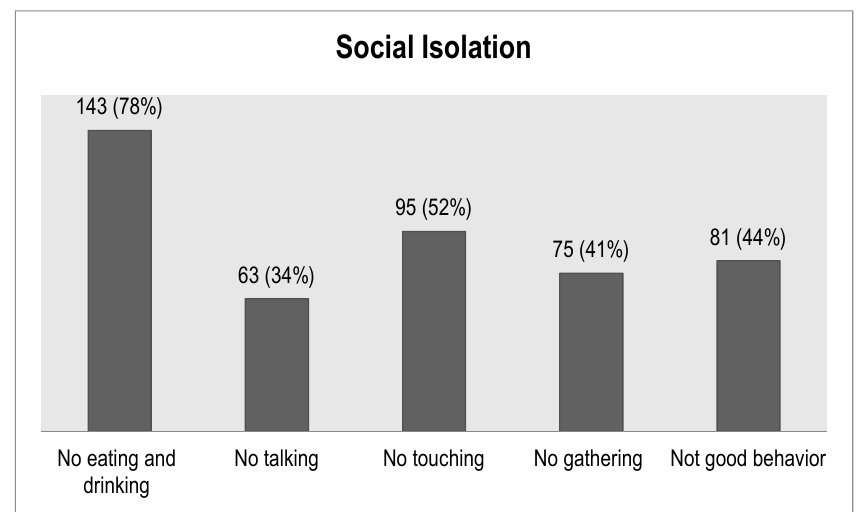
Figure 2. Community perception about isolating a person with TB.